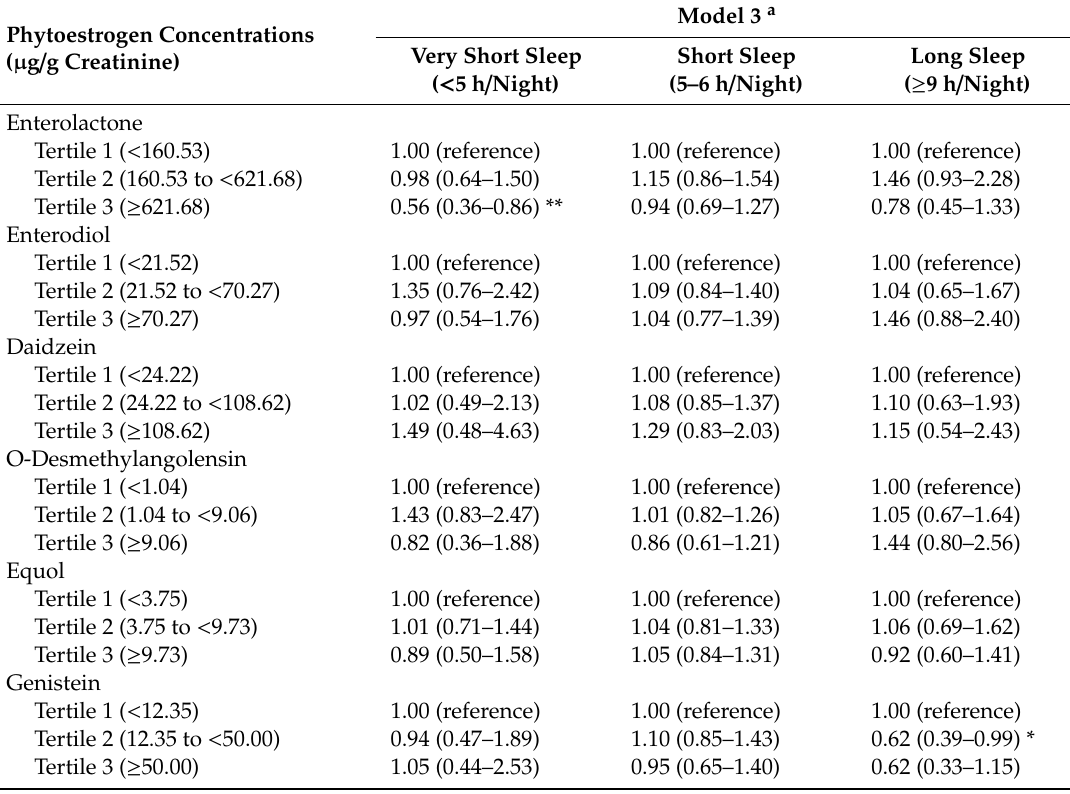
Table 7. Weighted relative risk ratios (95% confidence intervals) for sleep duration (reference, 7–8 h / night) across tertiles of the urinary phytoestrogen concentrations (National Health and Nutrition